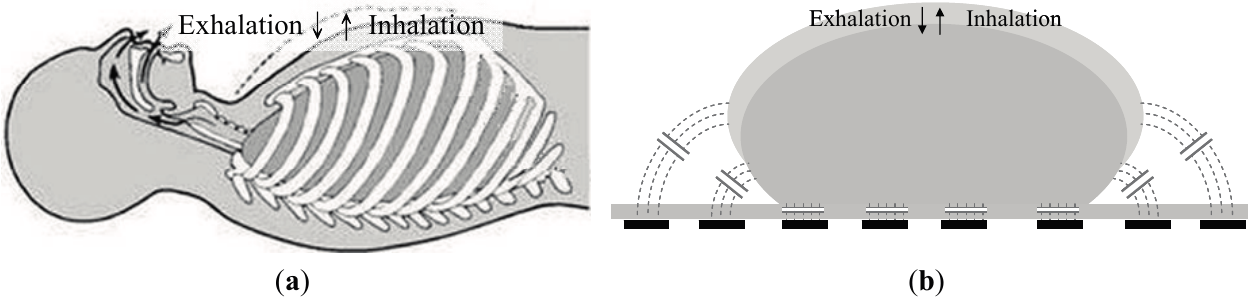
Figure 1. ( a ) Thoracic volume varies during respiration; ( b ) Concept of FPCSM operation during respiratory